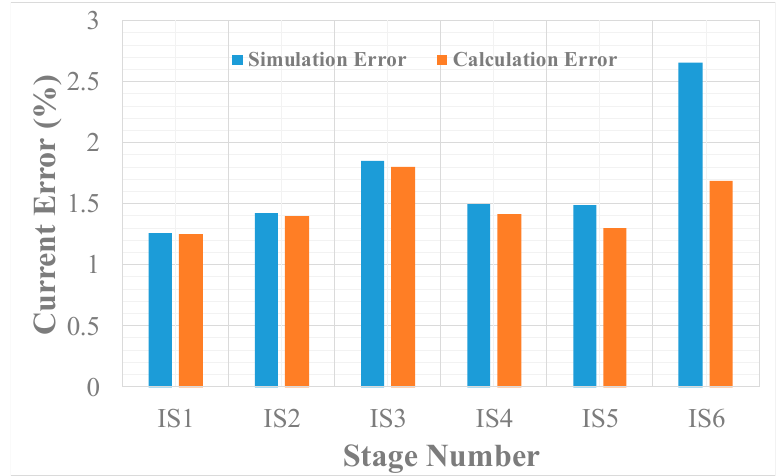
Figure 10. Comparison between simulated and calculated input currents errors per stage.